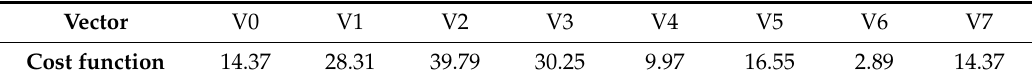
Figure 7. ( a ) The part of the flux vector tip trajectory in the PTC run. ( b ) The detail of the sector transition. At a marked point the voltage, vector V6 is applied in order to decrease flux amplitude and increase torque. The wrong vector V5 would be chosen according to Table 1 in the DTC case.